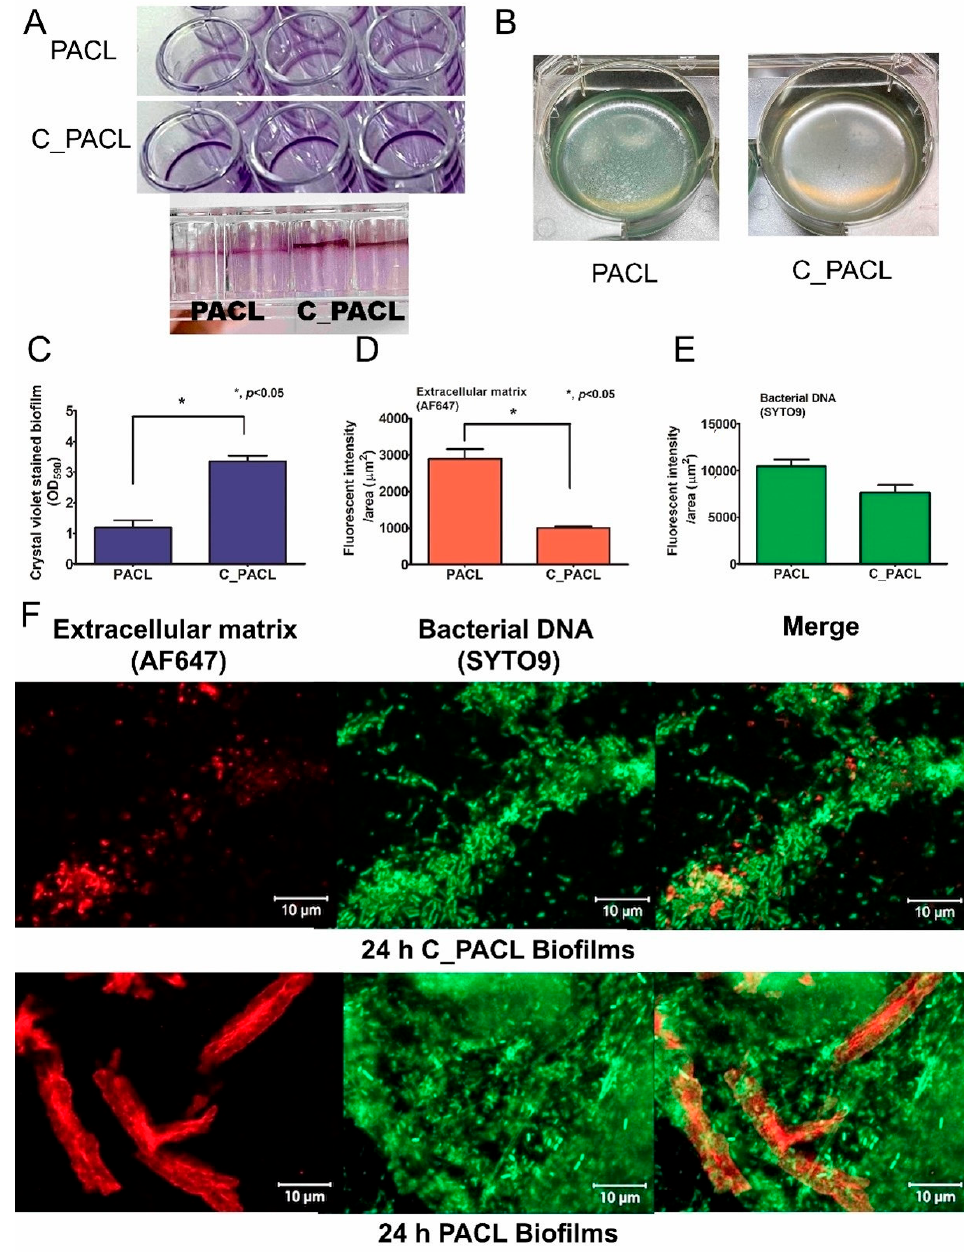
Figure 3. Biofilm characteristic of P. aeruginosa parent strain (PACL) and Chlorhexidine (CHG)-treated strain (C_PACL). The representative pictures of biofilms at the solid–liquid interface in 96-well polystyrene plates stained with crystal violet (the top and side views) ( A ) and the pellicle biofilms after incubation at the static condition for 24 h at 37 ◦ C (biofilms at the liquid-air interface) ( B ) are demonstrated in 6-well polystyrene plates. The intensity of crystal violet stain from 24 h biofilm in 96-well plates ( C ), and intensity of fluorescent stains from 24 h biofilm on cover glasses of P. aeruginosa for extracellular matrix (ECM) by AF647 (red color fluorescence) ( D ) or bacterial nucleic acid by SYTO9 (green color fluorescence) ( E ), and the representative fluorescent-stained pictures ( F ) are demonstrated. Mean ± SEM are presented with the unpaired t-test analysis (*, p ˂ 0.05). The representative fluorescent images of biofilms on glass coverslips stained for ECM by AF647 and bacterial nucleic acid by SYTO9 ( F ) are also demonstrated.